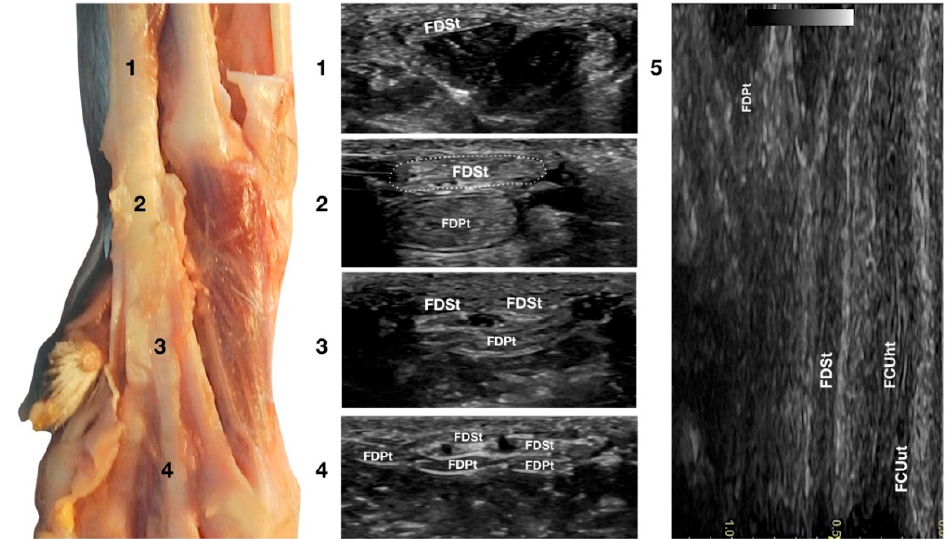
Figure 7. Palmar carpal face centred on the Flexor Digitorum Superficialis tendon. At the ulnar notch level (2), the FDSt is a broad and flattened elliptical structure surrounded by echoic ill-defined tissue (the Retinaculum ). It is just superficial to the larger Flexor Digitorum Profundus tendon. Proximally, the tendon is very superficial and flat at the tenomuscular junction (1). Distally, in the proximal third of the metacarpus (3), the tendon starts to divide into four structures that diverge and follow the more profound and larger parts of the FDPt (4). On the longitudinal scan (5), obtained by putting the probe in the hollow medially to the accessory carpal bone and angling the probe slightly laterally, the fine fibrillar pattern of the FDSt is seen parallel and separated from the more lateral and superficial FCUt by fat and the Retinaculum . The deeper FDPt is barely visible since it is not perfectly parallel to the other two tendons. The FDPt starts deeper and runs obliquely to become relatively superficial at the accessory bone passage where it pairs with the FDSt until their termination.